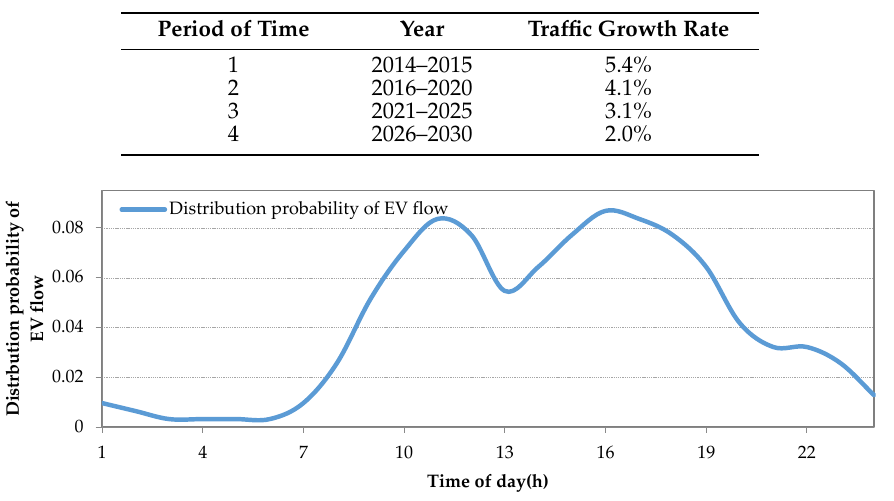
Figure 6. Probability distribution curve of traffic flow of EVs on primary road No. 1.